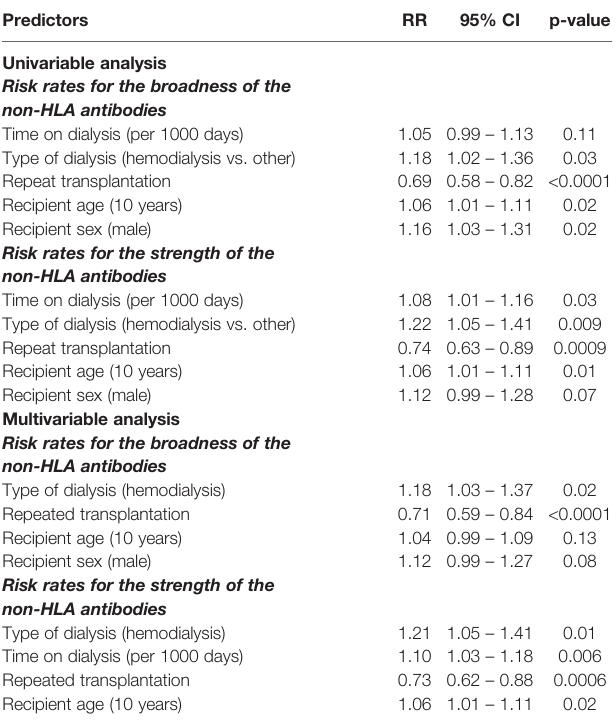
TABLE 2 | Multivariable Poisson regression analysis for estimating the relationships between different patient factors and the presence of pretransplant non-HLA antibodies